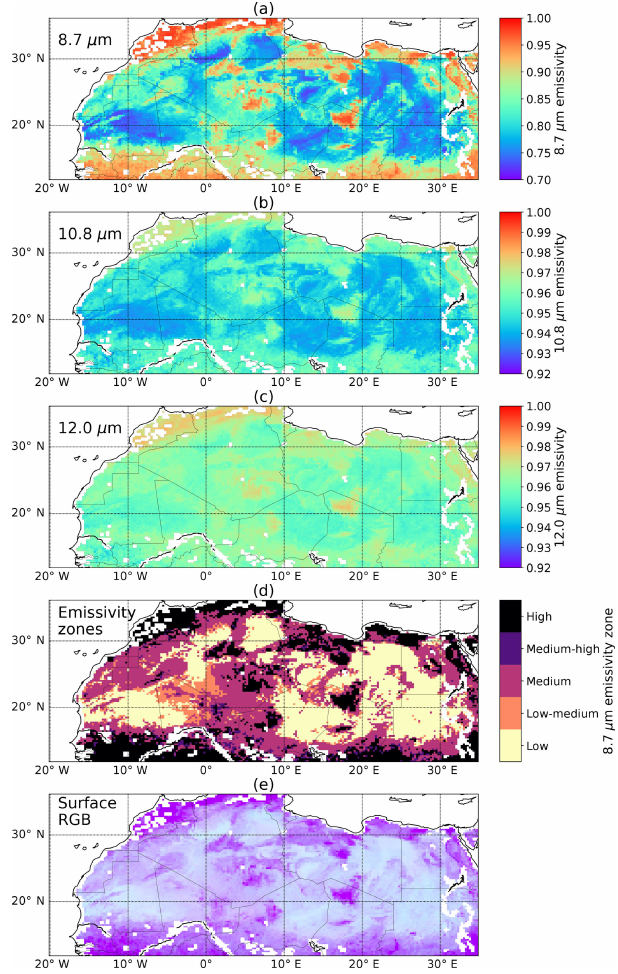
Figure 2. Maps of mean emissivities, June and July 2011–2013, for the SEVIRI channels at (a) 8.7µm, (b) 10.8µm, and (c) 12.0µm. Note that panel (a) has a different colour scale to panels (b) and (c) . These averages are built up from points where and when RTTOV simulations have been performed, i.e. only for land and cloud-free situations. White regions correspond to grid cells that contain some fraction of water. Panel (d) specifies which emissivity zone each grid cell falls into, at 8.7µm, which for some grid cells varies by month. The zones have emissivity ranges of 0.7–0.8 (low), 0.8–0.9 (medium), and 0.9–1 (high). Panel (e) depicts the Desert Dust com- posite image for the surface, calculated using the Planck function and using the emissivity values in panels (a) – (c) with a fixed skin temperature of 303.15K.